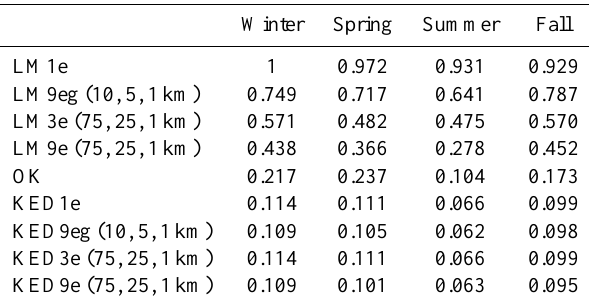
Table 5. Relative mean root-transformed error E calculated over all stations for different seasons using different interpolation models (see Table 1 for model